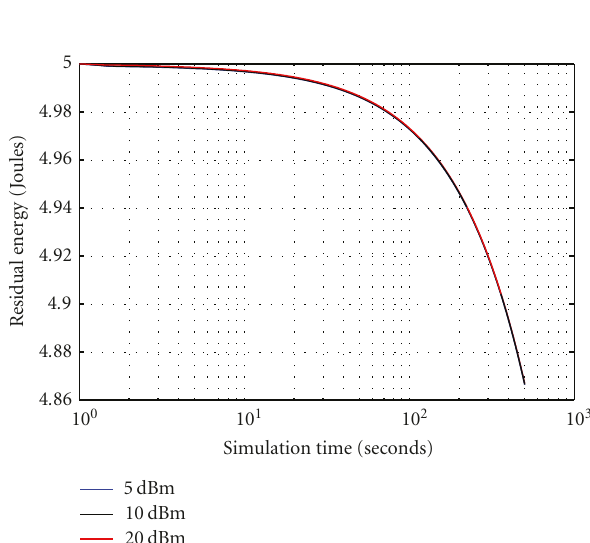
Figure 9: Packet delivery ratio.